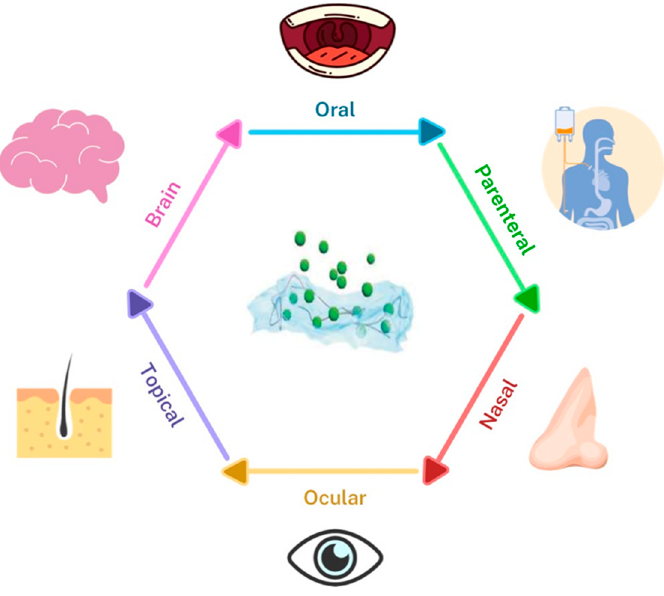
Figure 5. Schematic representation of the routes of administration of nanovesicle embedded hydrogel-based delivery platforms.